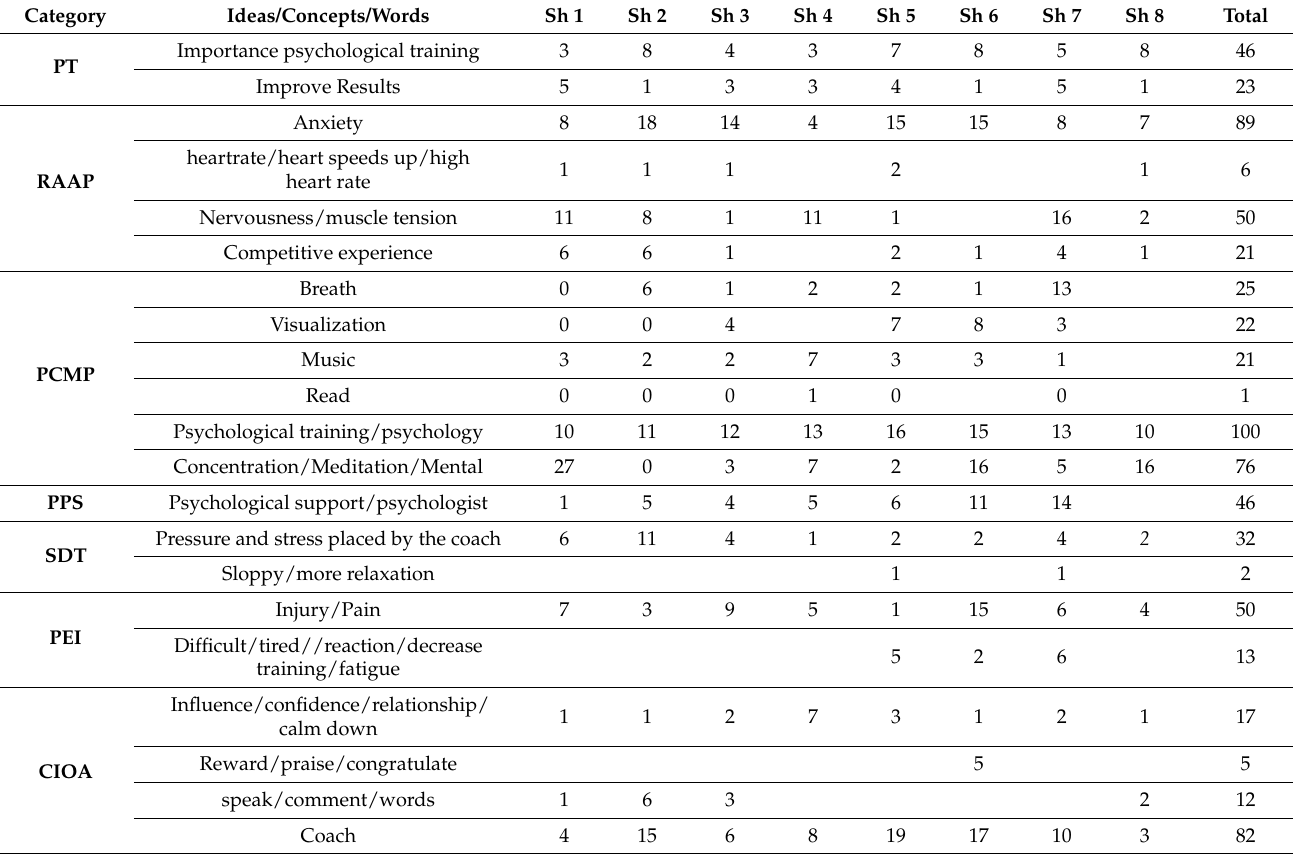
Abbreviations. Sh = Shooter. Importance of psychological training (PT), Relationship between anxiety and performance (RAAP), Precompetitive and competitive mental preparation (PCMP), Professional psychological support (PPS), Stress during training (SDT), Psychological effects of injuries (PEI), Coach’s influence on the athlete